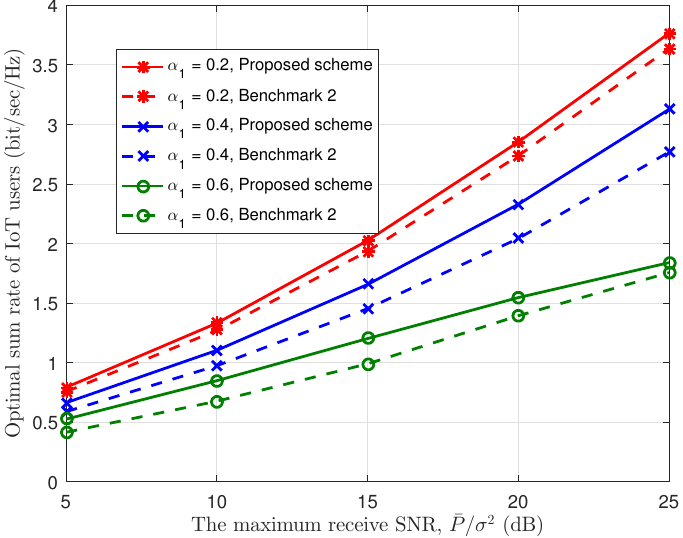
Figure 7. Optimal sum rate of IoT users vs. maximum IoT receive